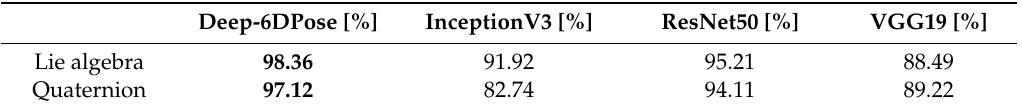
Table 1. Comparison of accuracies.